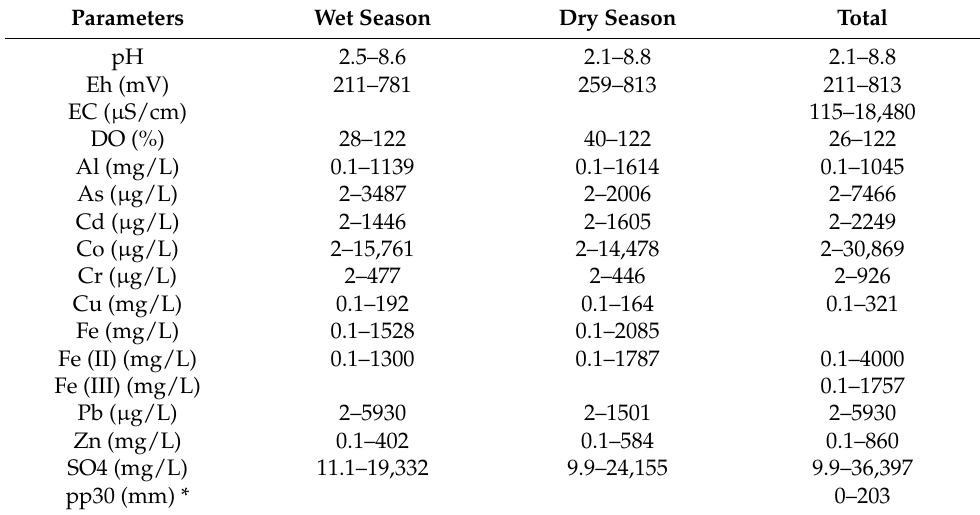
Table 2. Universe of discourse—range of parameter values—for data mining.